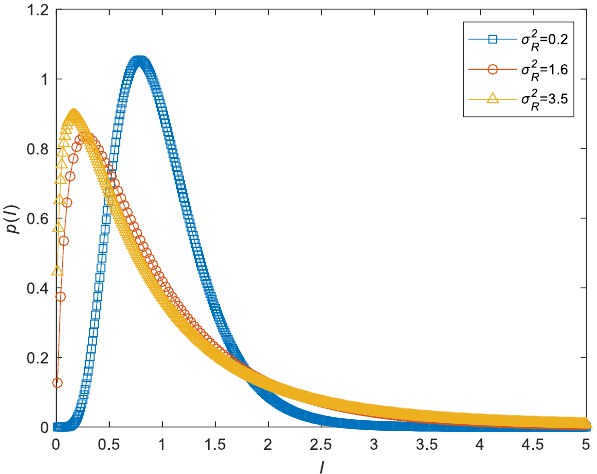
Figure 2. The distribution probability density function of the Gamma – Gamma.